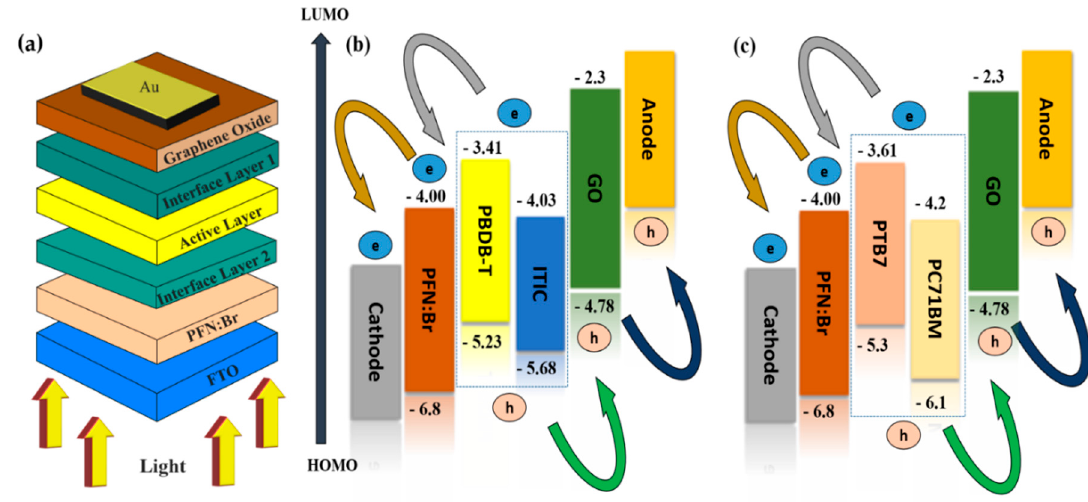
Figure 1. ( a ) Schematic representation of the device architecture; ( b ) HOMO and LUMO band diagram for PBDB − T:ITIC − based OSC; and ( c ) HOMO and LUMO band diagram for PTB7:PC71BM − based OSC. Table 1. Material parameters set in simulation.